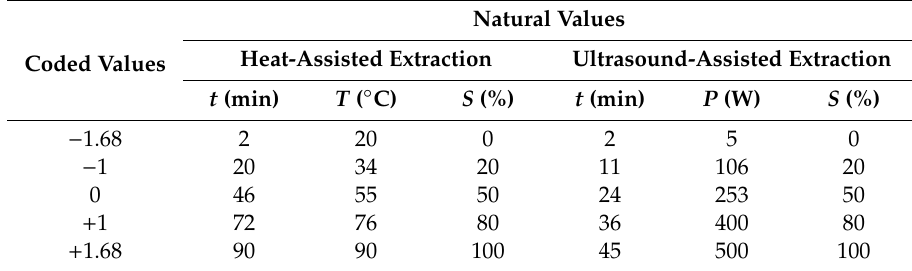
Table 1. Natural and codded values of the independent variables used in the five-level RCCD design implemented to optimize the heat- and ultrasound-assisted extraction processes using